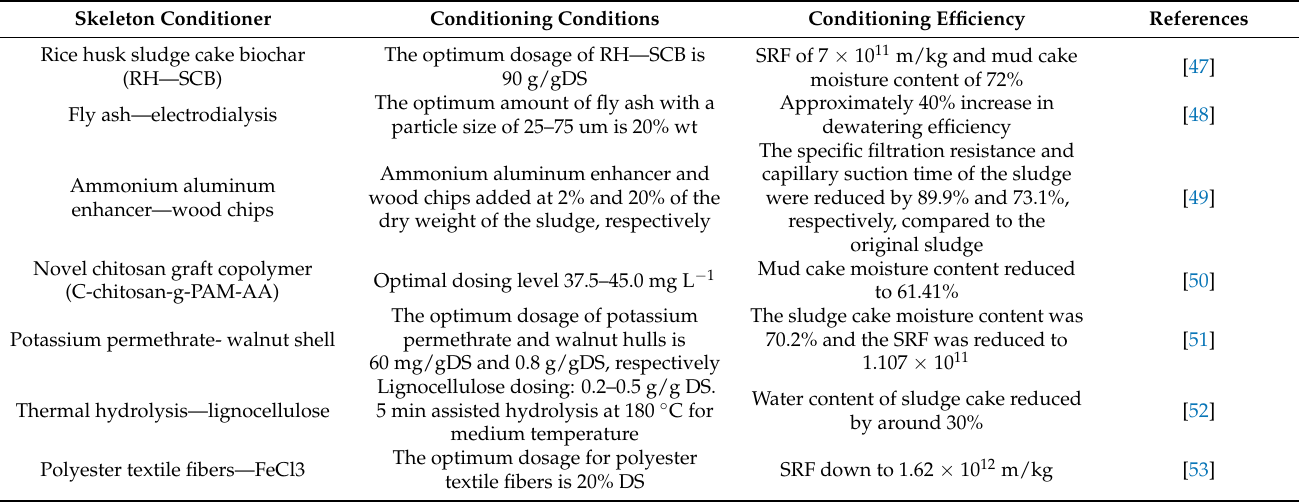
Table 6. Efficiency of sludge conditioning with different